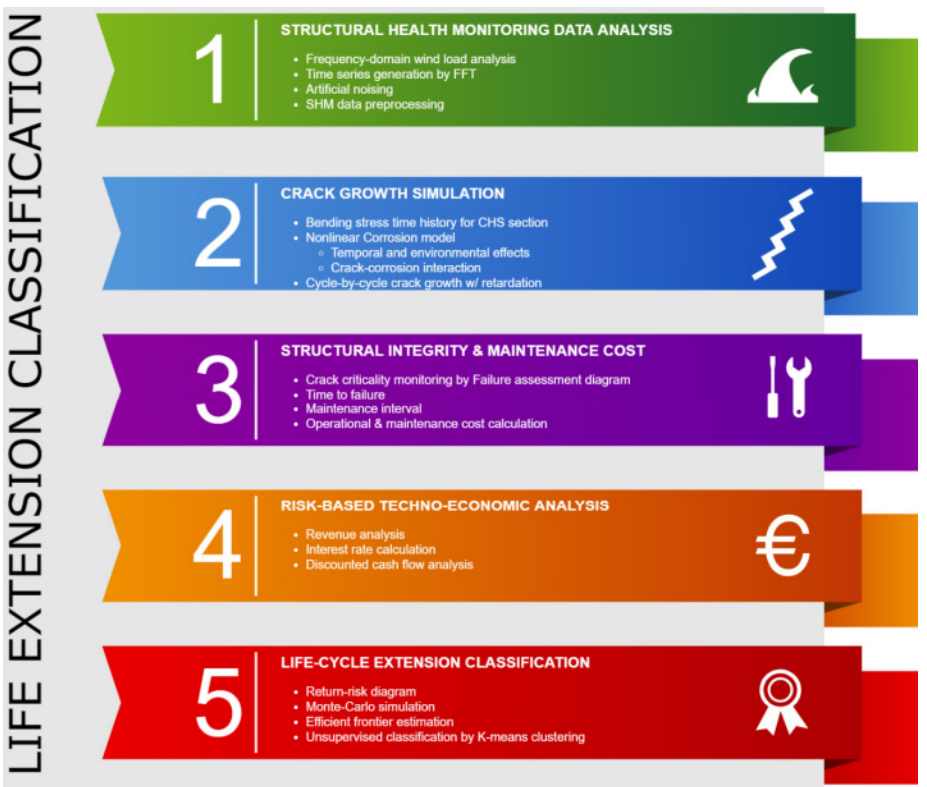
Figure 5. Flow chart for developing a typical life extension classification for an offshore wind farm. (Permission to use image is obtained from the authors—Baran Yeter and Yordan Garbatov, and used under MDPI open access rules. Publisher: MDPI, Copyright year: 2021, source: [196]).